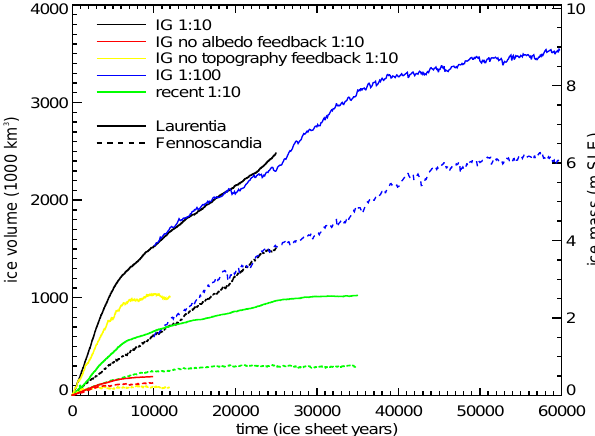
Fig. 5. Ice-sheet mass as a function of time through the whole length of the asynchronous (1 : 10 and 1 : 100) experiments. Glimmer do- mains are indicated by linestyle, and experiments by colour. Values are 100-yr